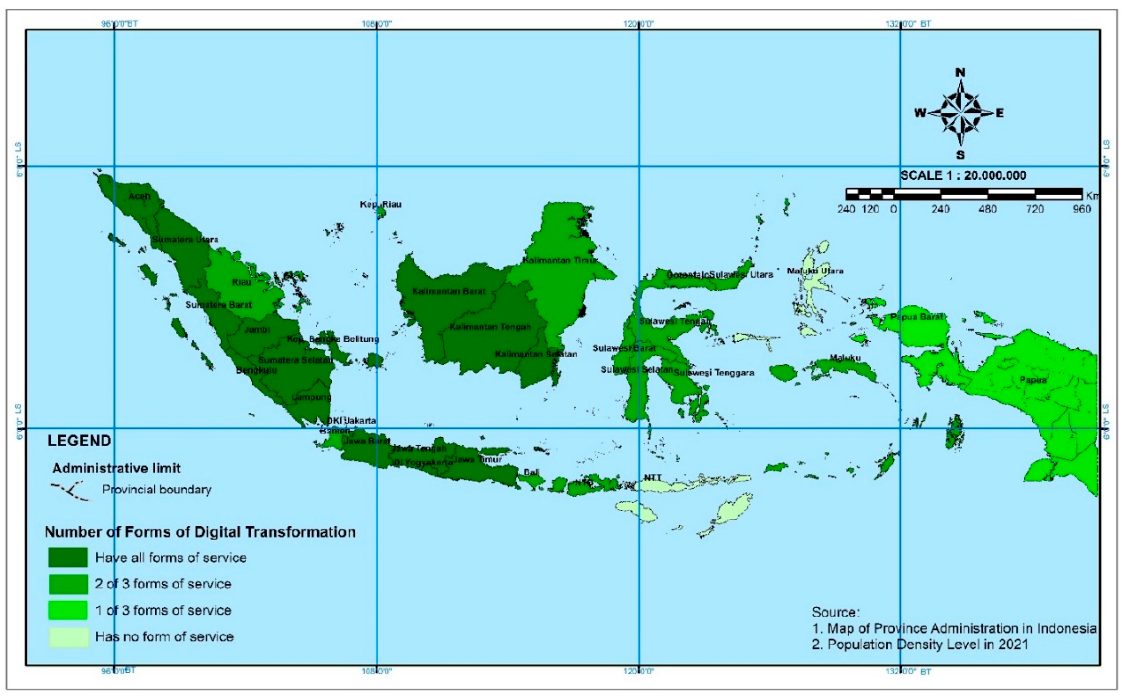
Figure 1. Typology Map of Digital Health Service Implementation in Indonesia. Source: Authors, 2022.